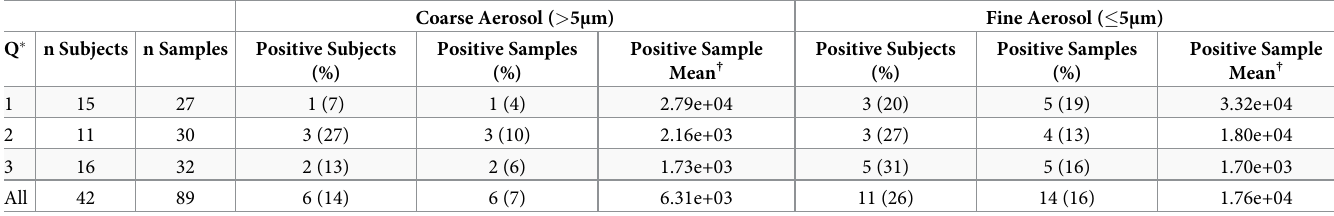
Table 2. Exhaled breath viral RNA detection and copy number among infected donors by quarantine event and aerosol fraction.